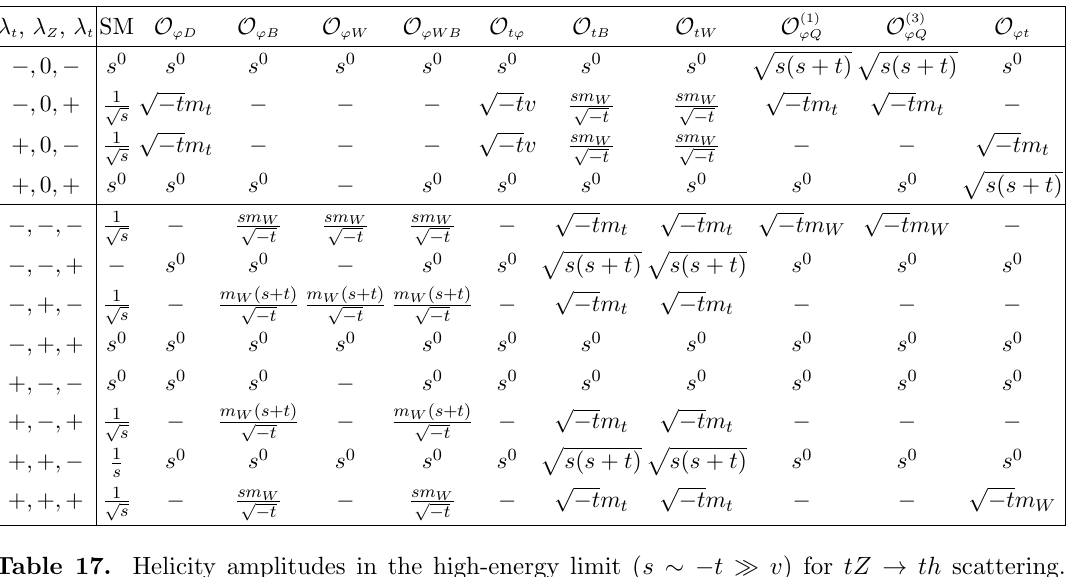
t v ) for tZ th scattering. (cid:24) (cid:0) (cid:29) ! ’ indicate any combination of ; . See (cid:3) (cid:6) (cid:7)